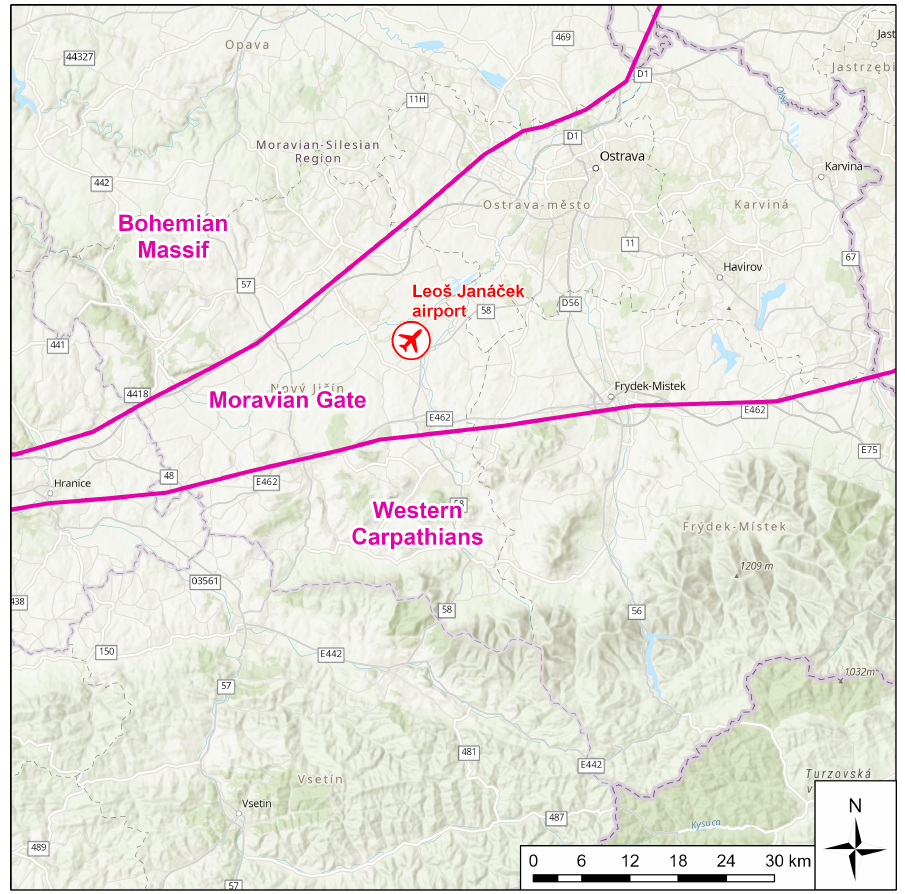
Figure 4. Moravian Gate, Basemap: ESRI Topographic Map.